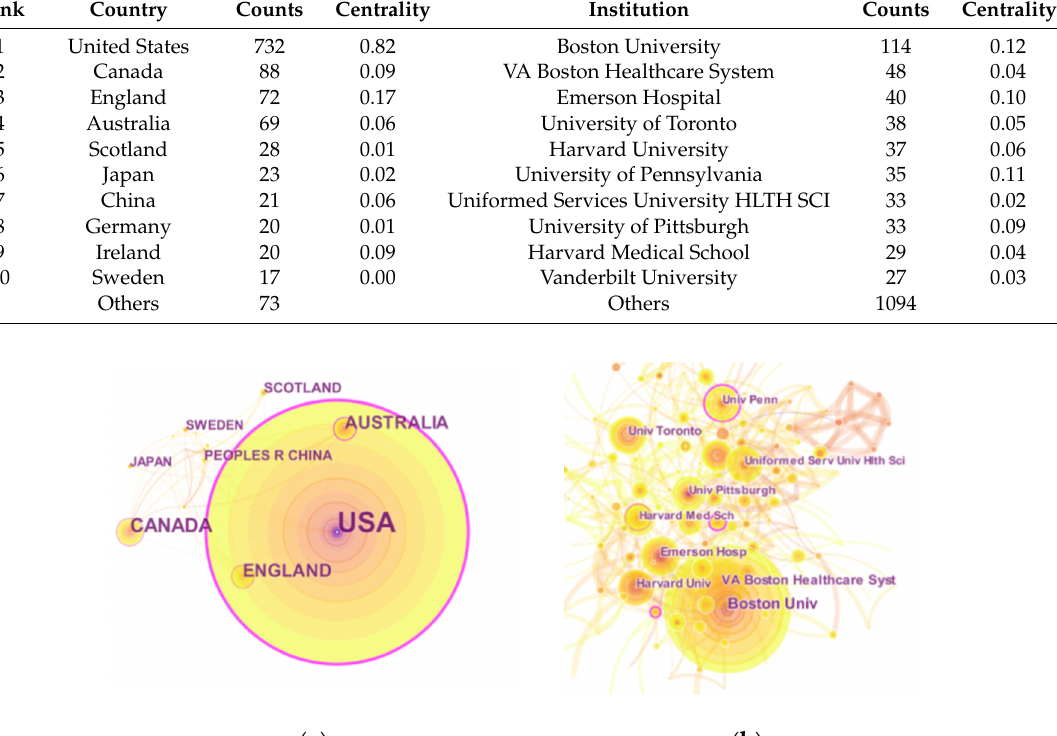
Table 1. Ranking of top 10 active countries and institutions in the field of CTE research from 1999 to 2019.